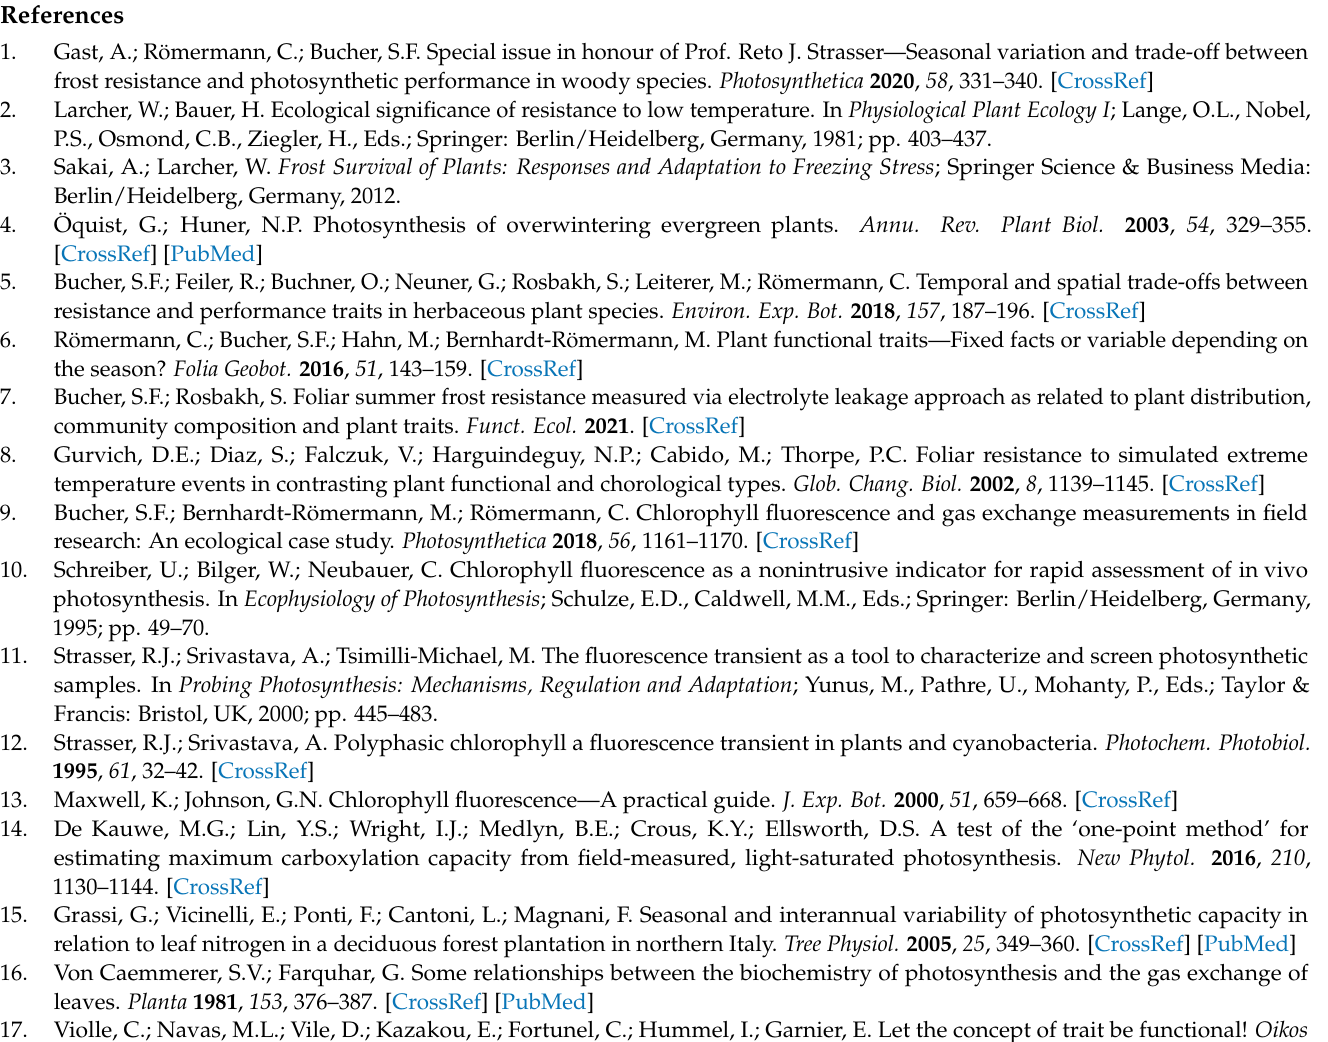
ilex . Figure S4: Graphical representation of differences in all parameters measured between the two lifeforms and the two temperature